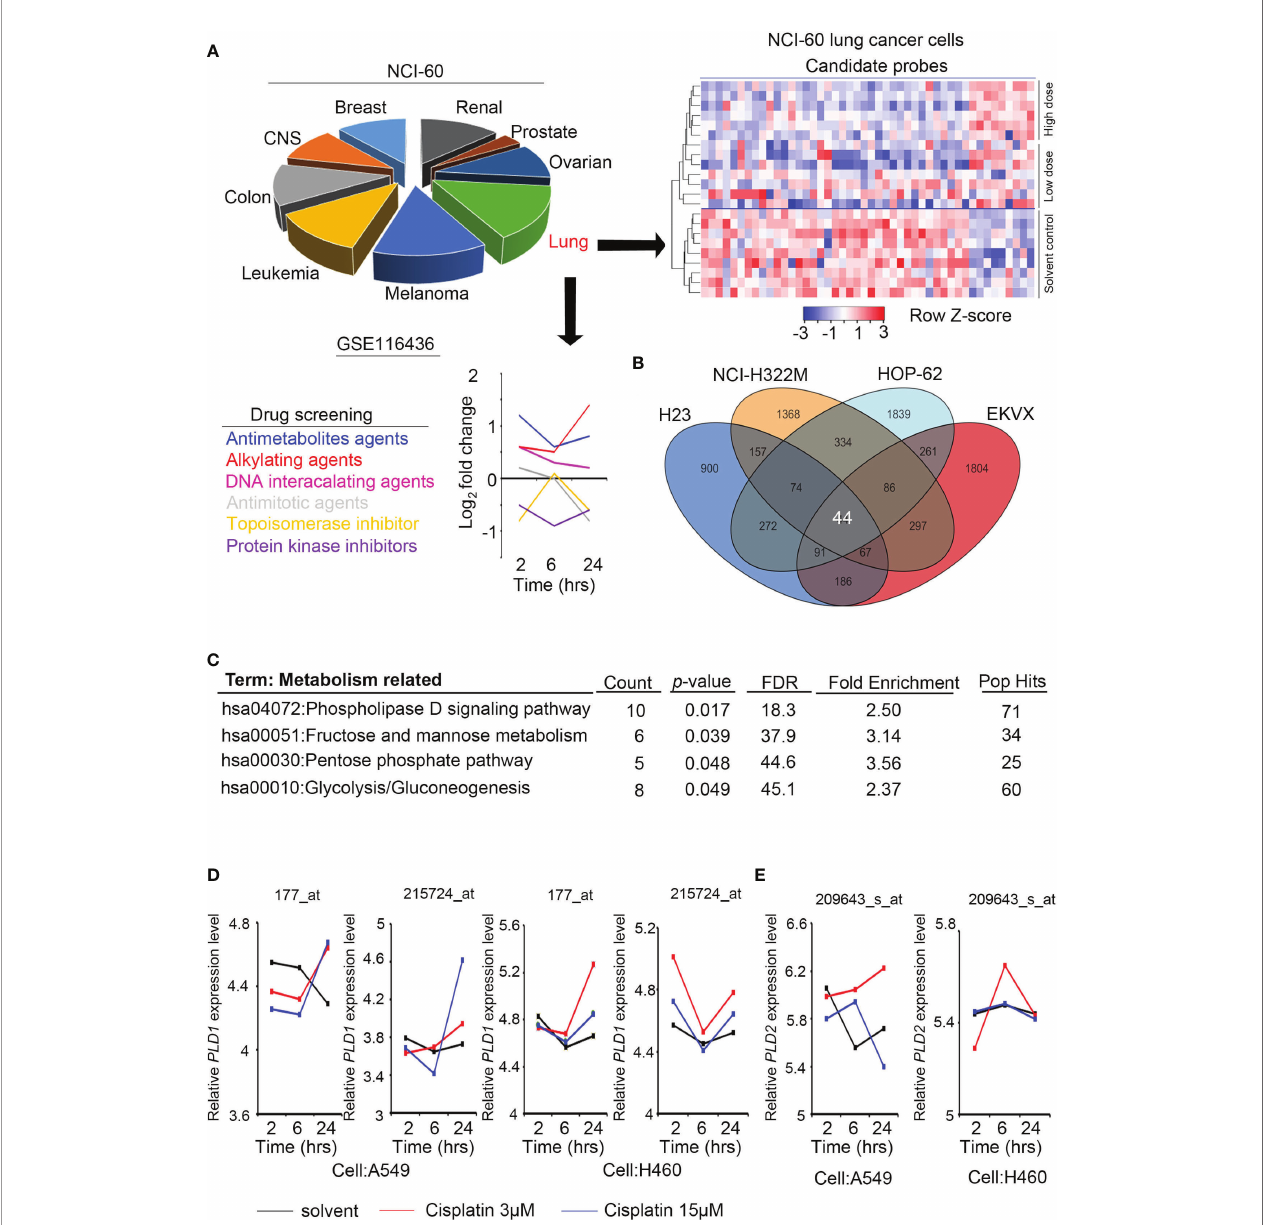
FIGURE 1 | Phospholipase D expression in lung cancer cells with alkylating agent events. (A) The cell models in the GSE116436 pro fi le are classi fi ed according to NCI-60, and only lung cancer models are extracted and quanti fi ed for various drug response analyses. The heat map contains candidates whose high/low dose vs. control >1.5 fold-changes. (B) The Venn diagram shows the overlapping targets of GSE116436 during treatment of the alkylating agents in four lung cancer cells (H23, NCI-322M, HOP-62, and EKVX). (C) KEGG predicts the highest ranking of metabolic and canonical pathways based on selected features of the 44 candidates in panel (B) . (D) The expression level of PLD1 in lung cancer cell lines was detected in the GSE116436 pro fi le. Conditions include cisplatin 3 m M and 15 m M. The drug treatments were 2, 6, and 24 hours, respectively. (E) The expression level of PLD2 in lung cancer cell lines was detected in the GSE116436 pro fi le. Conditions include cisplatin 3 m M and 15 m M. The drug treatments were 2, 6, and 24 hours,